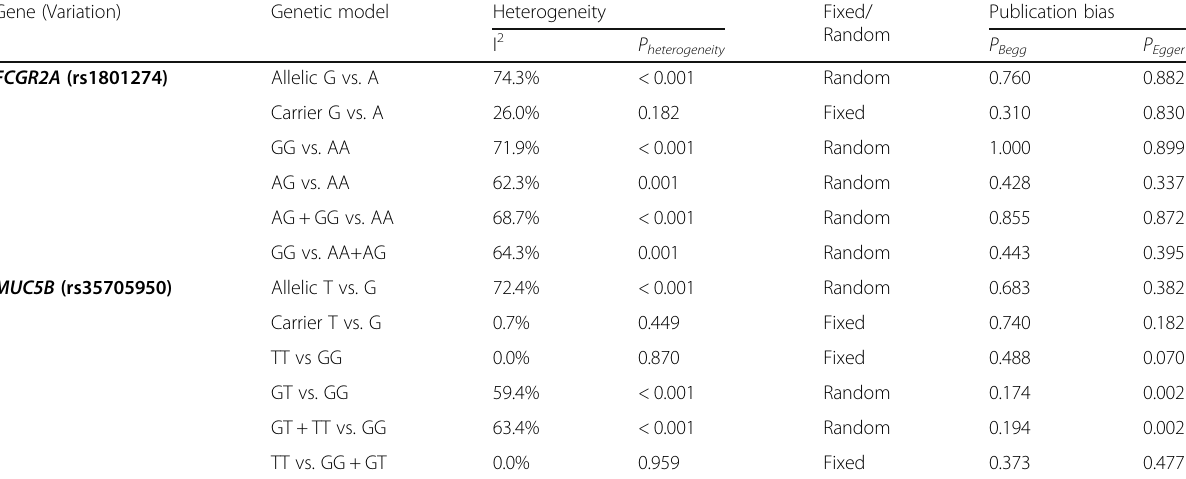
Table 2 Data of heterogeneity assessment and publication bias analysis Gene